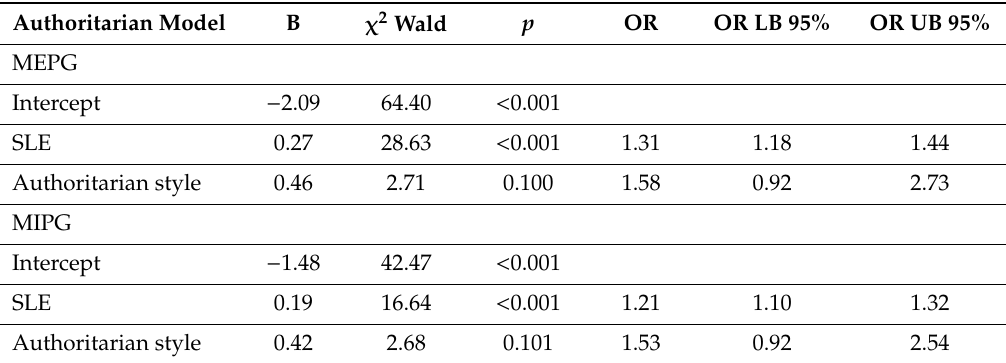
Table 6. Multinomial logistic regression model parameters using the AG as a reference and authoritarian style as